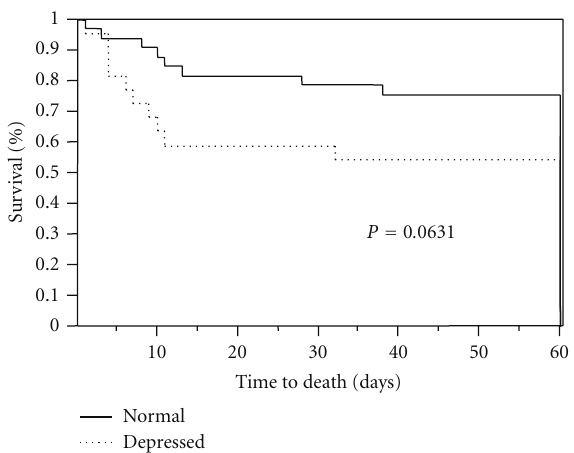
Figure 1: Kaplan-Meier survival curve for patients with echocar- diographic findings of depressed LV function and normal LV func-